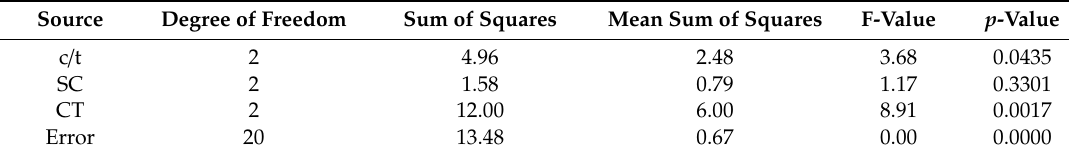
Table 4. Analysis of variance (ANOVA) values of shrinkage